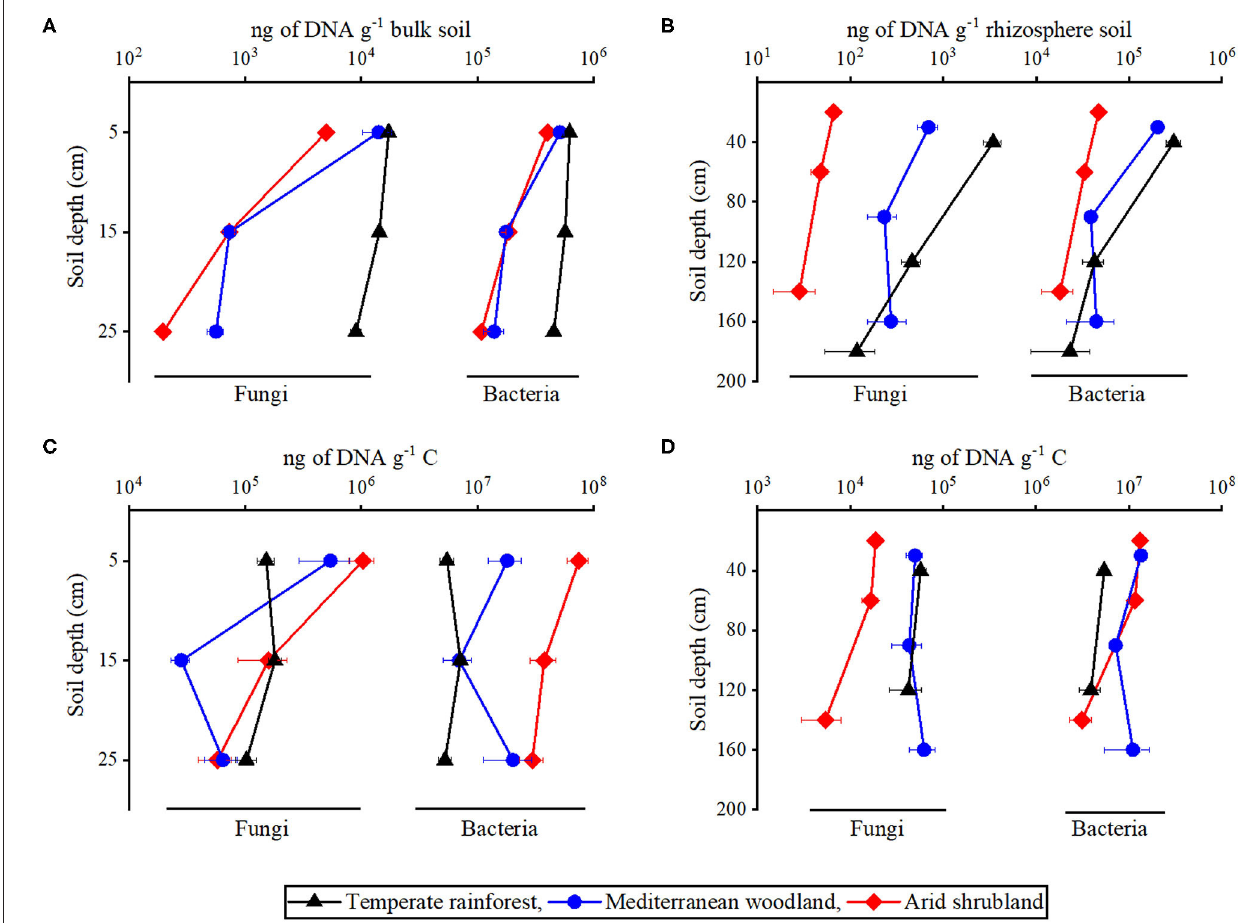
FIGURE 4 | Quantification of microbial abundance along the depth in (A,C) bulk topsoil and (B,D) rhizosphere by qPCR using bacterial (Bac27f/338r) and fungal (NL1f/LS2R) primers in temperate rainforest, Mediterranean woodland, and arid shrubland. Data in A and C are expressed as ng of DNA per g soil, while in (B,D) they are expressed as ng of DNA per g organic carbon as sampled from the soil profile wall. Data represent means of four biological replicates, with three technical replicates for every biological replicate. Error bars represent standard errors of the